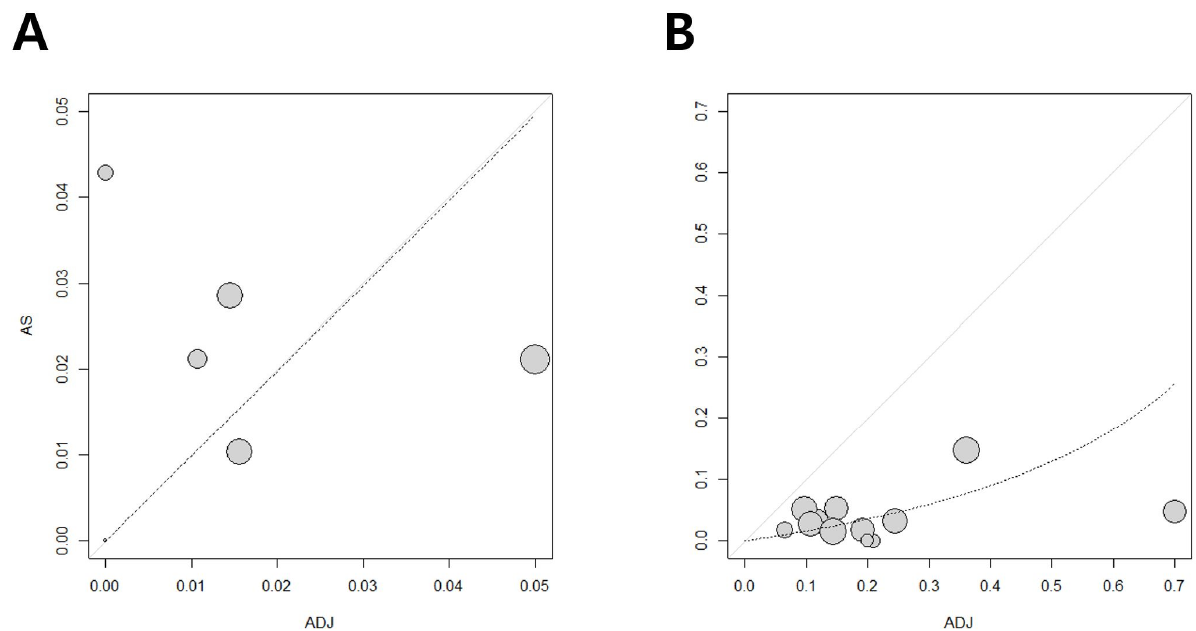
Figure 5. L’Abbe plots of 5-year overall survival (OS) ( A ) and 5-year recurrence-free survival (RFS) ( B ). A little heterogeneity was noted in the L’Abbe plots.